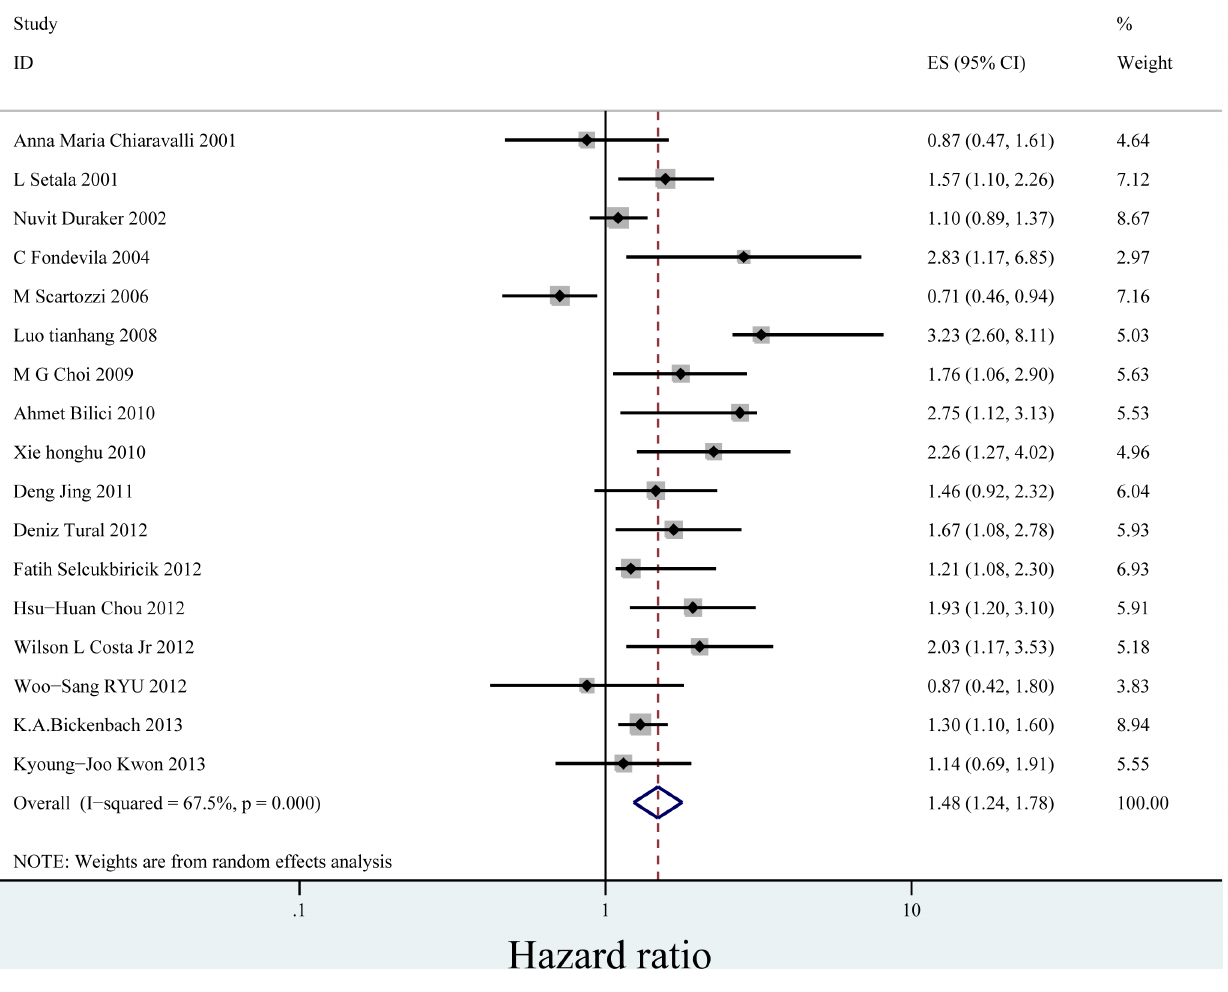
Figure 2. Forrest plot of combined hazard ratio for the association of PNI and OS in multivariate analysis.